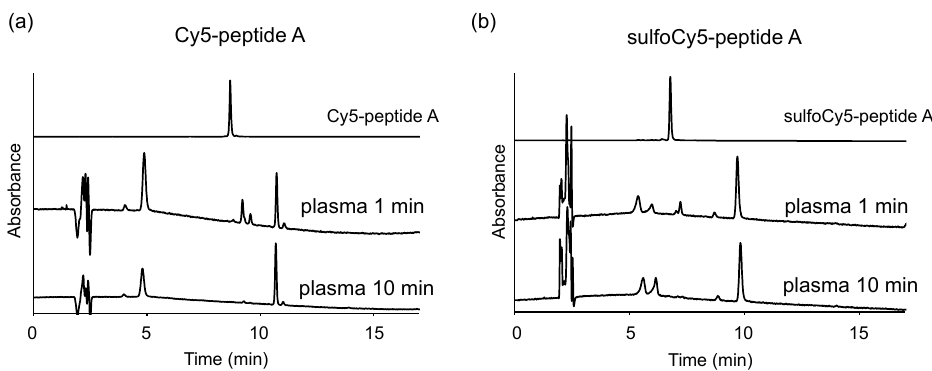
Figure 7. The time course of the concentration of Cy5/sulfoCy5-peptide A in mouse plasma. The data represent the mean ± SEM ( n = 3).